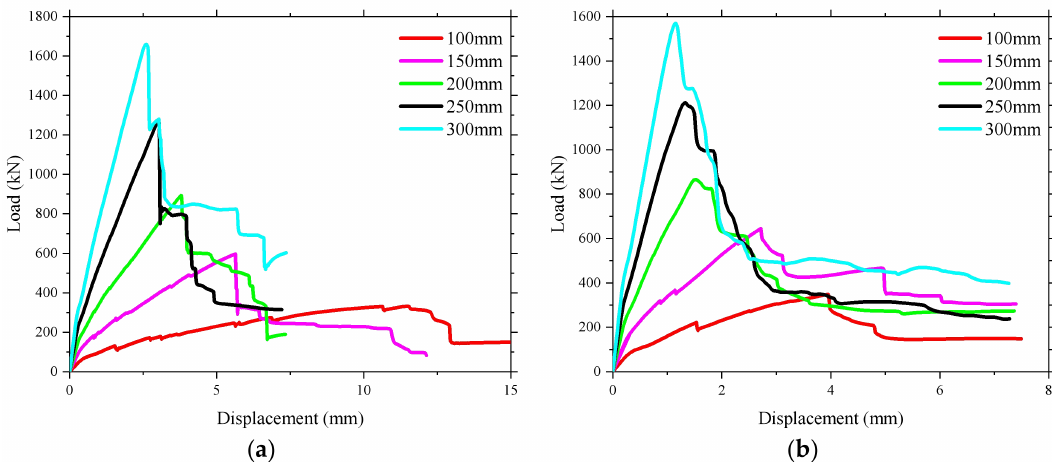
Figure 28. Influence of the depth of the bridge deck slab on the ultimate bearing capacity. ( a ) Loading between the W-beams; ( b ) Loading between W-beams and W-beams.